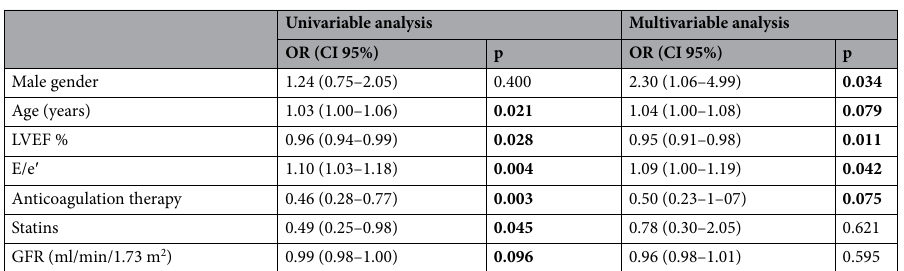
Table 2. Univariable and multivariable analysis for in-hospital mortality in hospitalized patients with SARS- CoV-2 infection. Values are presented as odds ratio and 95% confidence intervals. Bold values denote statistical significance at the p < 0.10 level. GFR glomerular filtration rate, LVEF LV ejection fraction. The five variables included in the final model were: male gender, age, LVEF, E/e ′ and anticoagulation